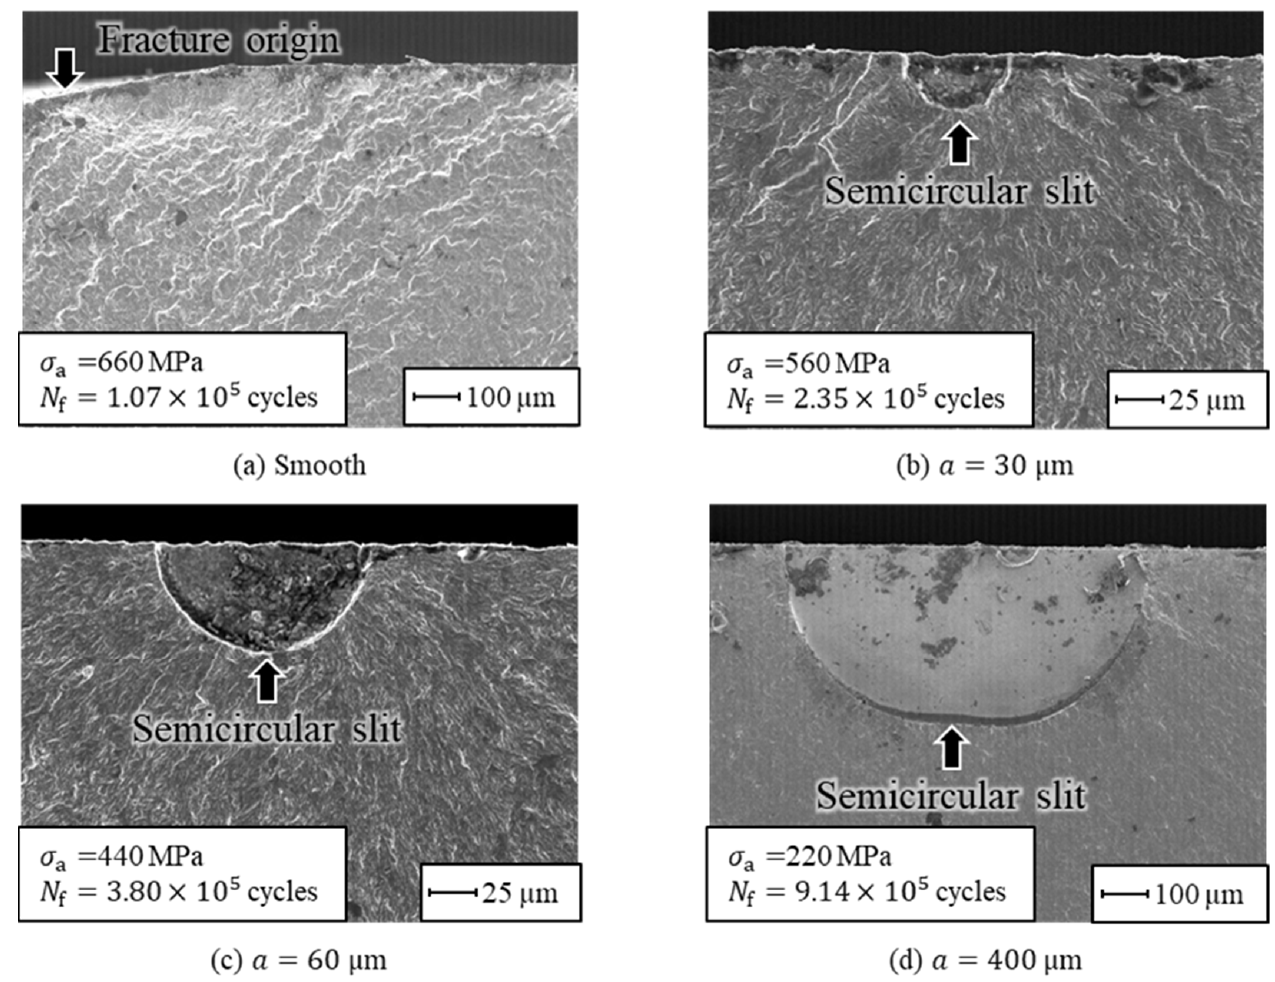
Figure 8. Surfaces of fatigue-fractured specimens ( R = − 1 ) . ( a ) Smooth, ( b ) a = 30 µ m, ( c ) a = 60 µ m, ( d ) a = 400 µ m.